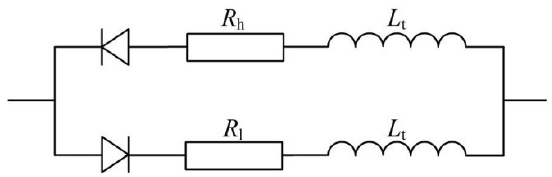
Figure 5. Equivalent circuit of tubes with fluid resistance differences.